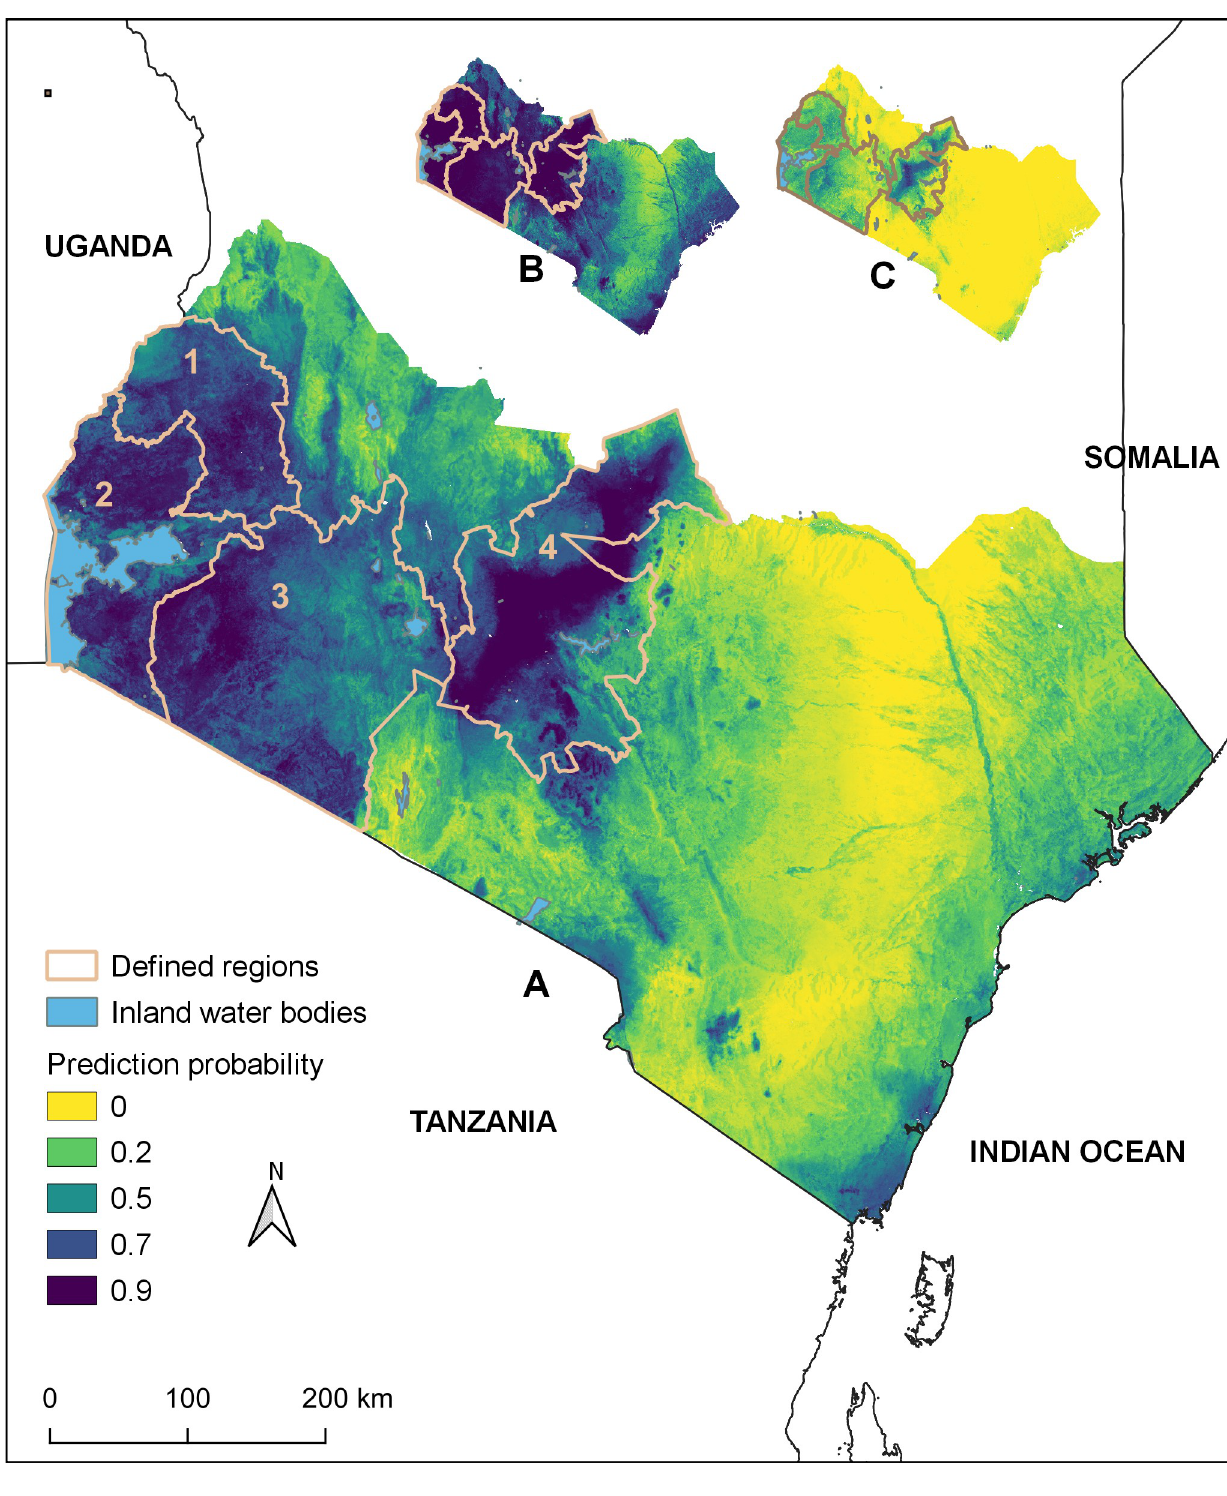
Fig 2. Panel A: Predicted geographic distribution of anthrax in southern Kenya based on the mean prediction of an ensemble of 100 boosted regression tree experiments. Panel B shows the upper 97.5% and C the lower 2.5% confidence intervals. Regions 1–4 are used as reference areas for the discussion: 1) western highlands; 2) Lake Victoria basin; 3) southwestern region; 4) central highlands.